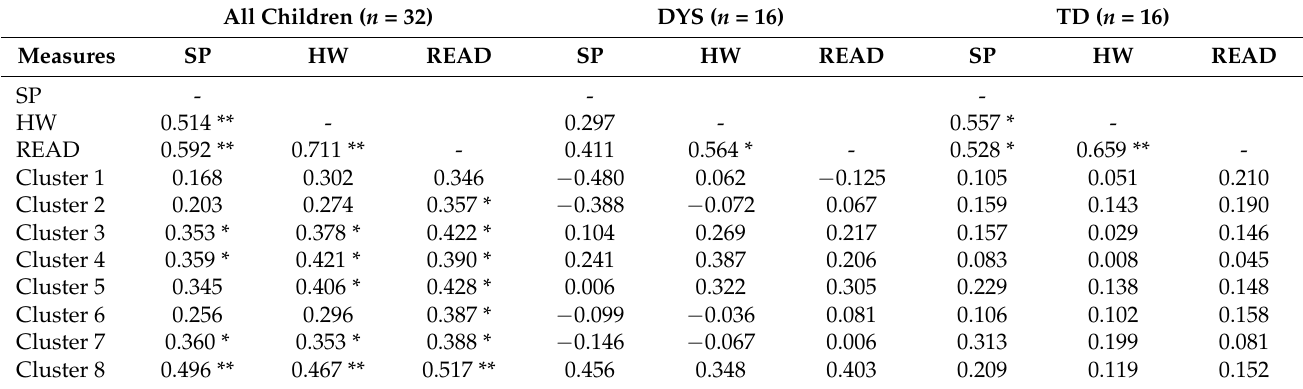
Table 3. Pearson correlations between behavioural measures and RSFC between the GMFA seed region and the eight clusters.